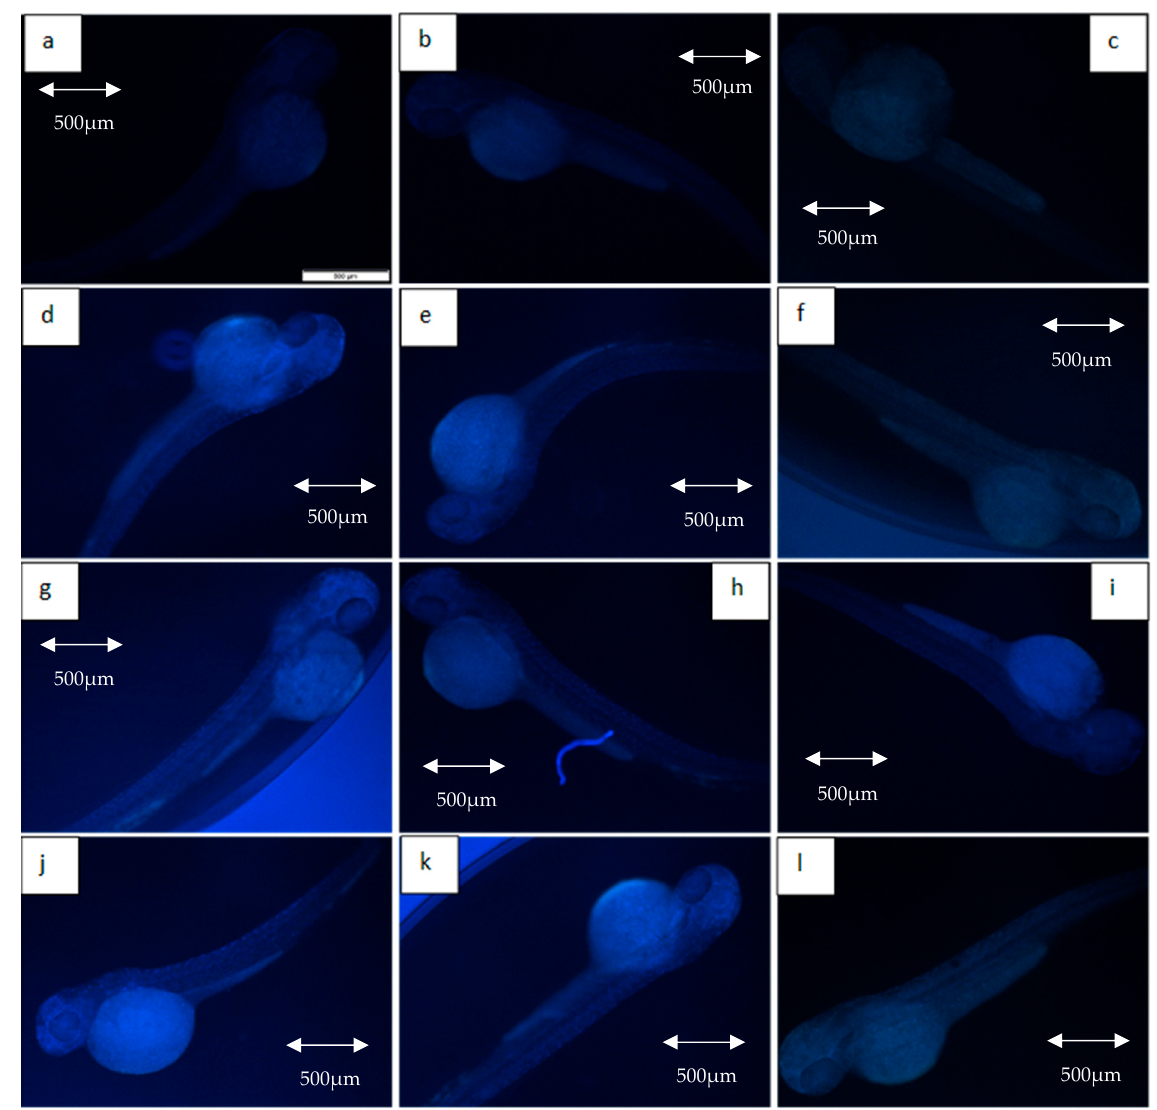
Figure 7. Expression of γ -H2AX in non-irradiated and irradiated zebrafish embryos. ( a ) Control without any treatment (non-irradiated); ( b ) control pre-treated with KH (non-irradiated); ( c ) control pre-treated with amifostine (non-irradiated); ( d ) untreated embryos irradiated at 11 Gy; ( e ) embryos pretreated with KH and irradiated at 11 Gy; ( f ) embryos pretreated with amifostine and irradiated at 11 Gy; ( g ) untreated embryos irradiated at 15 Gy; ( h ) embryos pretreated with KH and irradiated at 15 Gy; ( i ) embryos pretreated with amifostine and irradiated at 15 Gy; ( j ) untreated embryos irradiated at 20 Gy; ( k ) embryos pretreated with KH and irradiated at 20 Gy; ( l ) embryos pretreated with amifostine and irradiated at 20